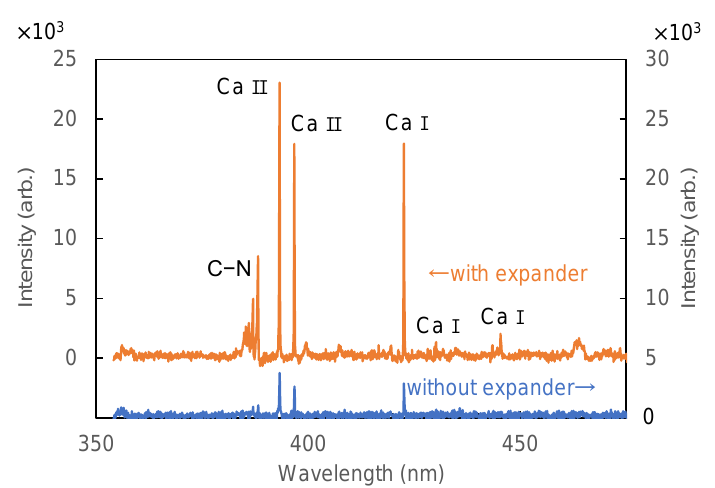
Figure 3. LIBS spectra of hair measured with and without an expander.